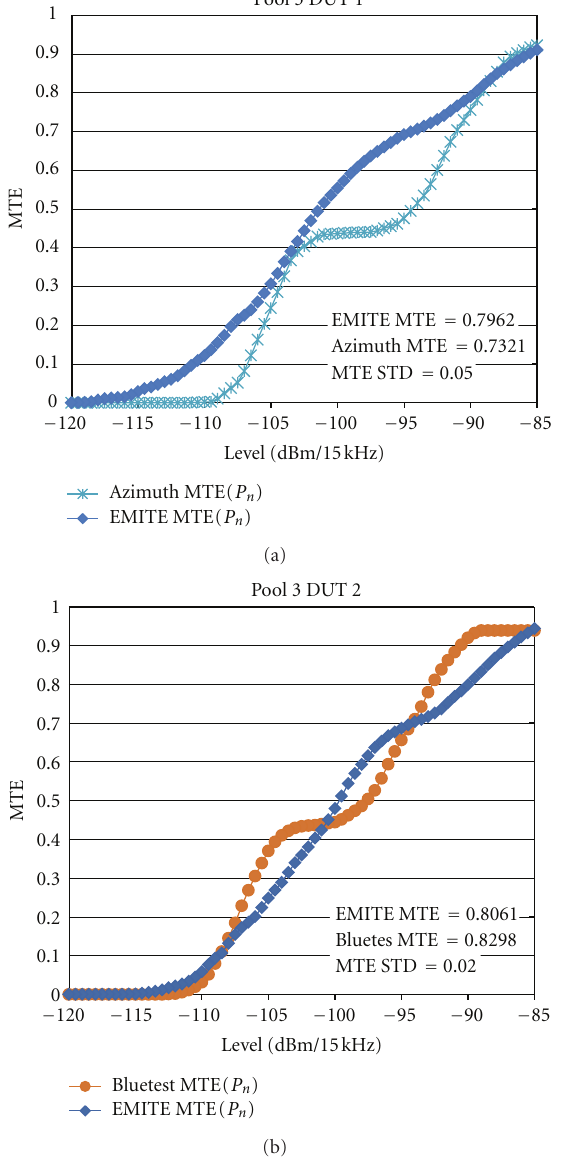
Figure 5: MTE for the RC